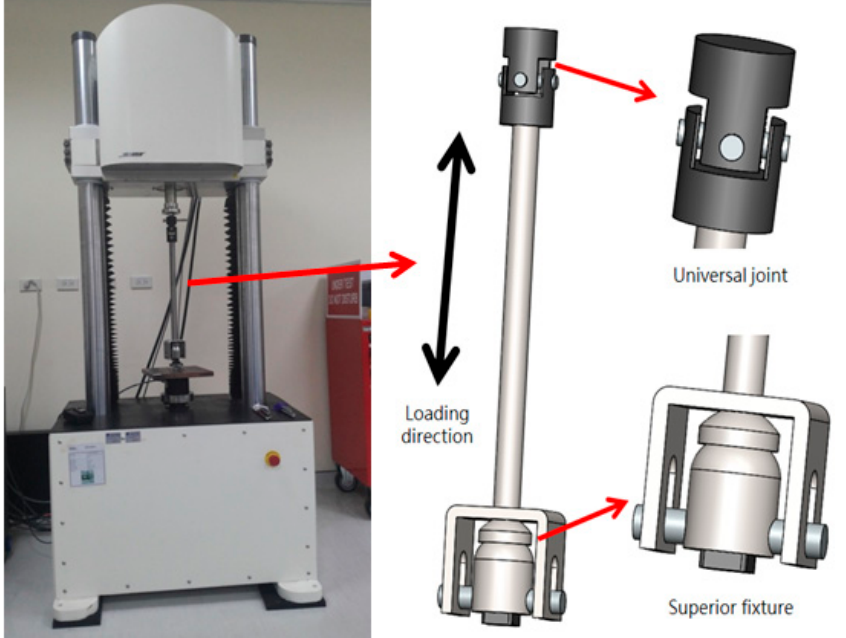
Figure 5. Instron 5582 universal testing machine and SHIMADZU HMV-2 Vickers microhardness test machine.